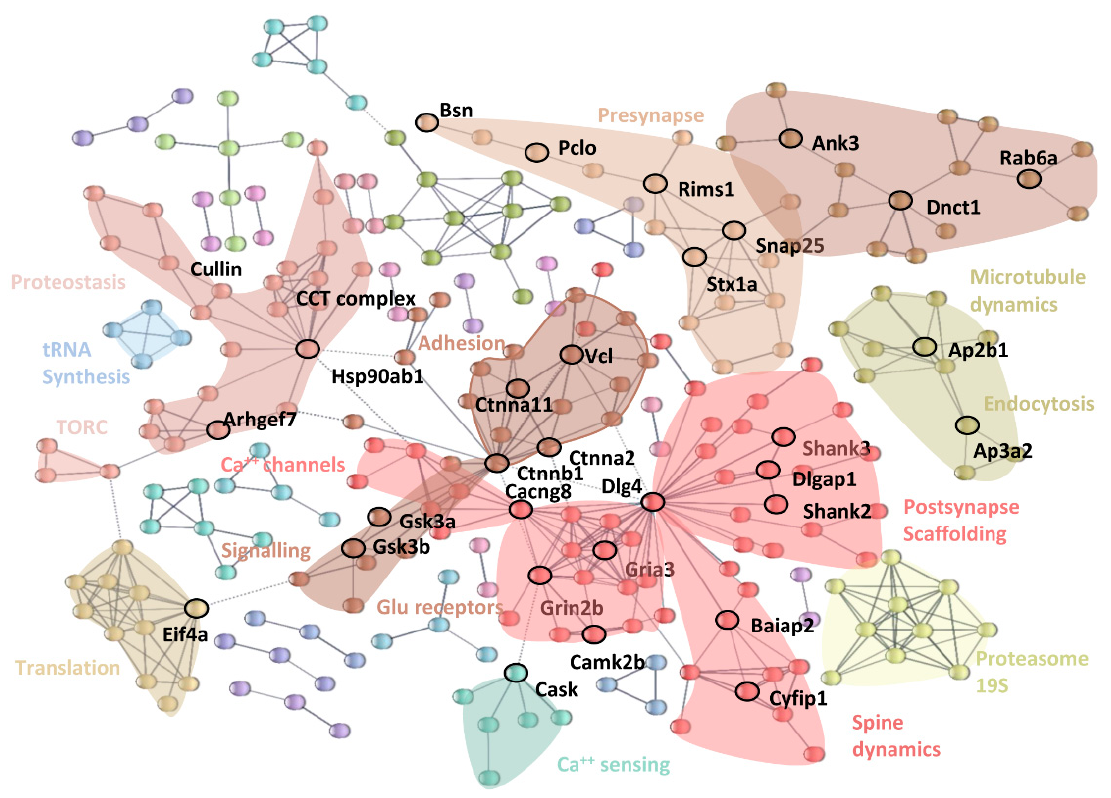
Figure 5. STRING Interactome of the up-regulated proteins in the contrast RC vs. SC. Each node in the graph represents a protein. Edges represent experimentally proven physical interactions with high confidence. Singletons, i.e., up-regulated proteins whose interactors are not up-regulated, are not displayed. Colors identify different clusters generated by Markov Cluster Algorithm (MCL) with parameter 1.3. Clusters particularly relevant for plasticity are highlighted as convex hulls of a different color and the names of particularly relevant genes/hubs are also displayed.